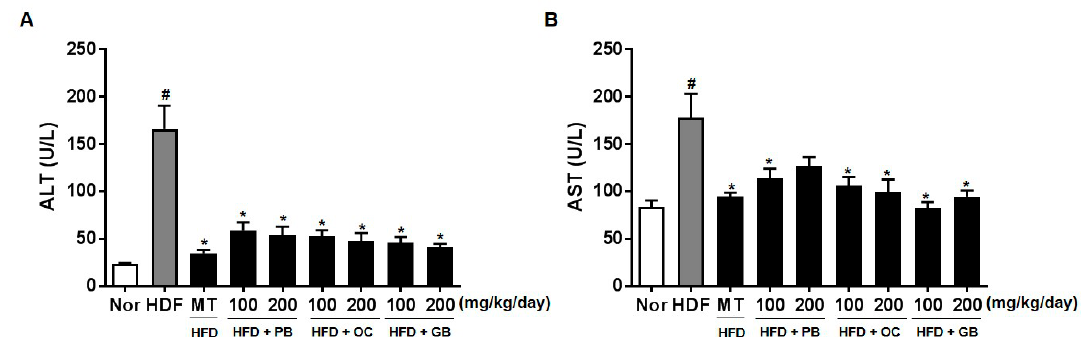
Figure 4. Effects of PB, OC, and GB extracts on serum alanine aminotransferase (ALT) and aspartate aminotransferase (AST) levels in HFD-fed mice. The serum ALT ( A ) and AST ( B ) levels were determined 14 weeks after PB, OC, and GB extracts treatment. The data are presented as the mean ± SEM ( n = 9); # p < 0.05 compared with the control group; * p < 0.05 compared with the HFD group.